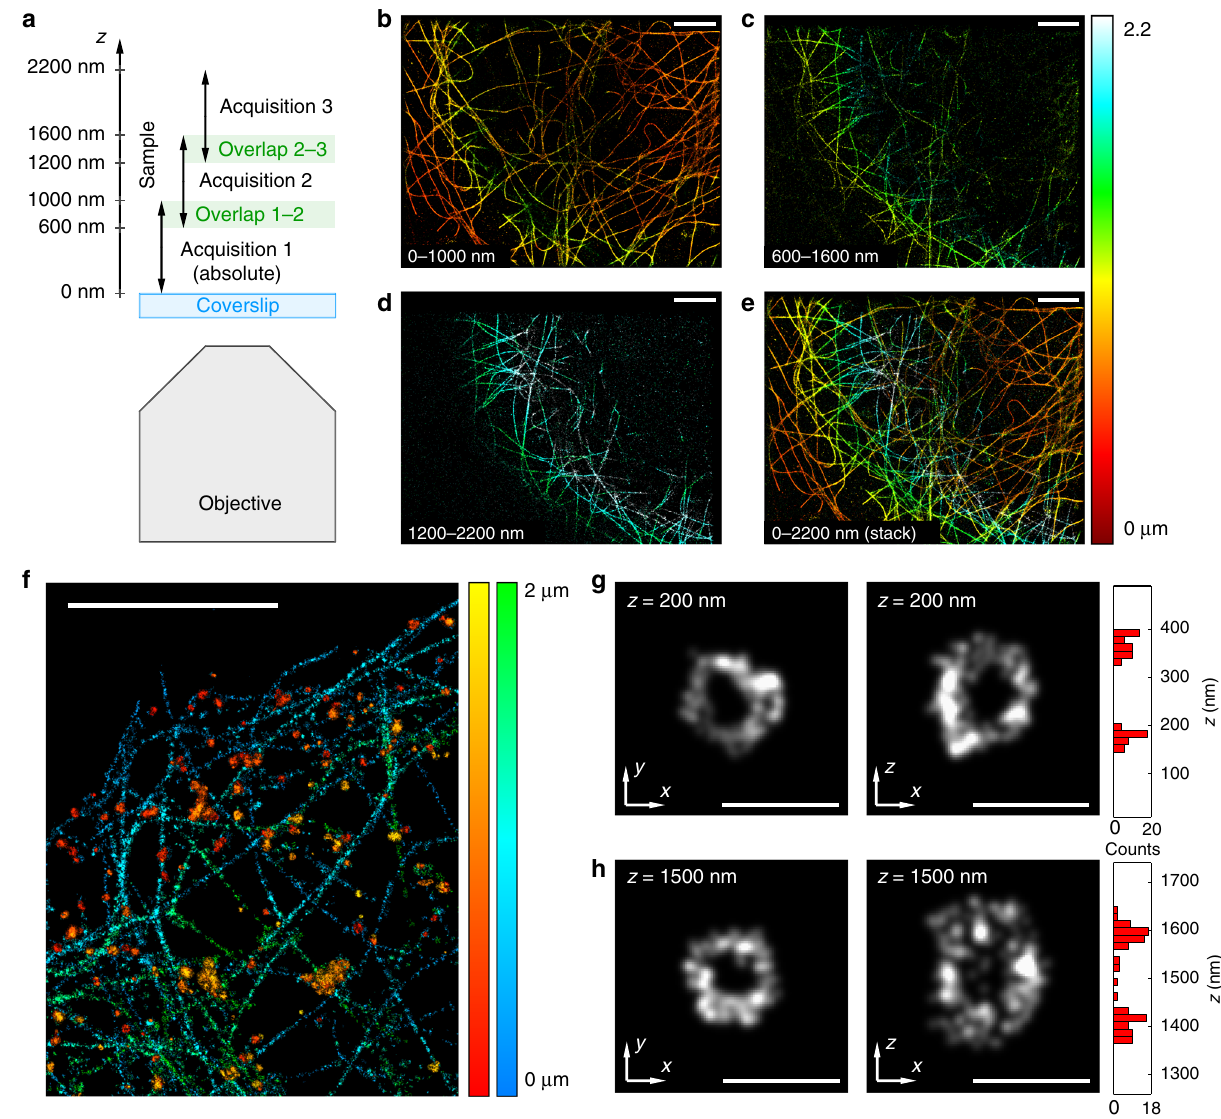
Fig. 4 Extended depth imaging principle and results. a Description of the acquisition protocol: several sequential acquisitions are performed at different focus positions with a suf fi cient overlap between them to enable the stitching of the different slices (the focus is typically shifted by 600 nm between successive acquisitions, while the capture range is around 1 μ m for each acquisition). b – d 3D images reconstructed from single-color tubulin acquisitions performed at three different focus positions (COS-7 cells, α -tubulin and β -tubulin labeled with AF647). e Final 3D image obtained by stitching the three consecutive acquisitions. The total range is around 2.2 μ m. f 3D extended range dual-color image of clathrin (red-yellow) and tubulin (blue-green) obtained from three sequential acquisitions (for each color) at different heights (COS-7 cells, heavy chain and light chain clathrin labeled with AF647, α -tubulin and β -tubulin labeled with a 560-nm excitable DNA-PAINT imager). g , h x – y and x – z slices of two clathrin spheres taken from ( f ) at two different depths (200 and 1500 nm). The axial histograms of the x – z images are displayed on the right. Scale bars: 5 μ m ( b – f ), 250nm ( g , h